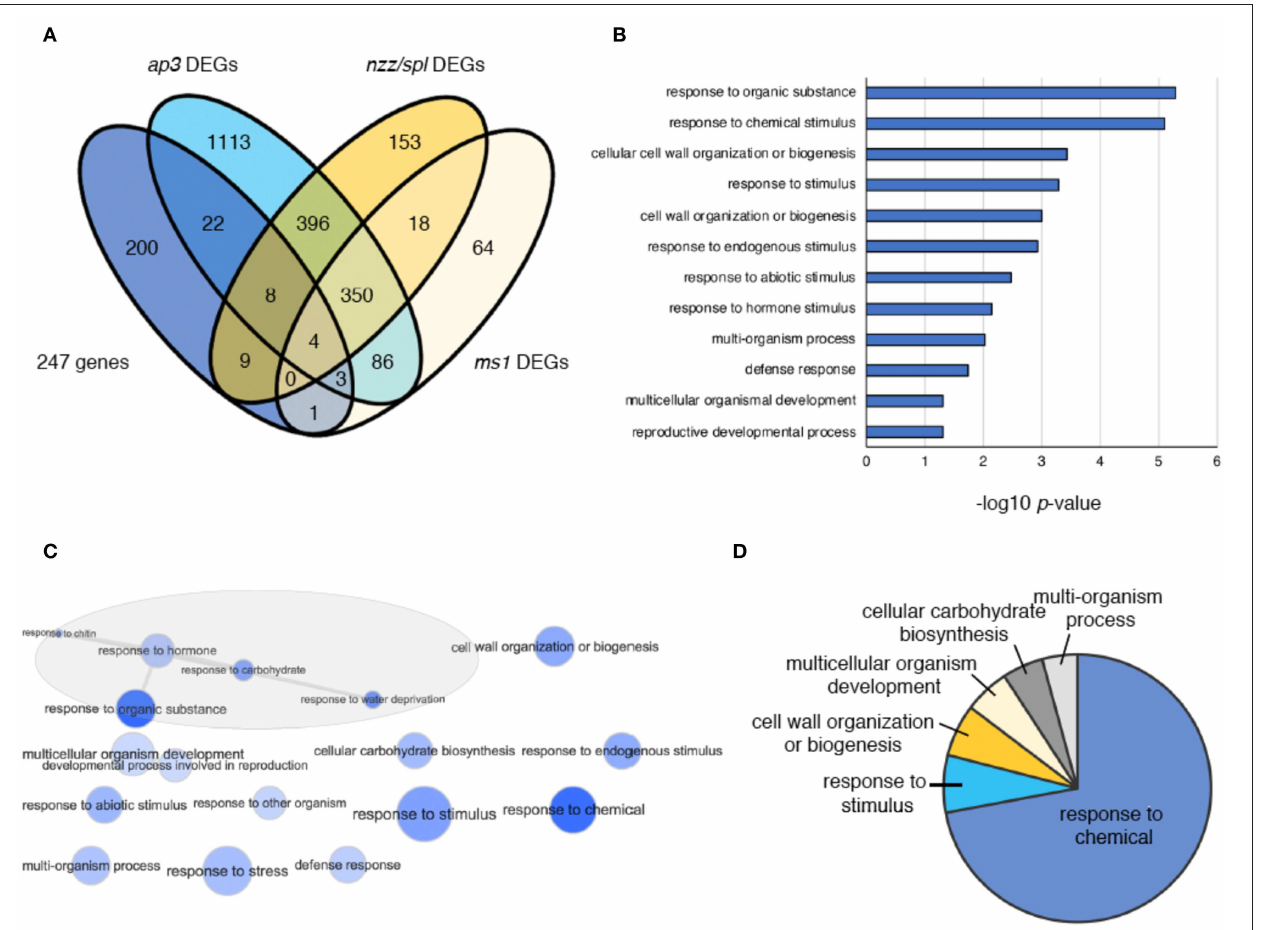
FIGURE 5 | DEGs in crc sup , ap3 , nzz/spl , and ms1 flowers. (A) Venn diagram showing 247 DEGs in ap3 , nzz/spl , and ms1 . (B) GO term enrichment analysis of 47 genes coregulated by CRC and SUP and related to stamen development. Selected terms determined by their –log 10 -adjusted p -values are shown. (C) The interactive graph view of 47 genes generated by REVIGO. (D) Pie charts showing summarized GO terms by REVIGO for 47 genes within the GO-term category “biological